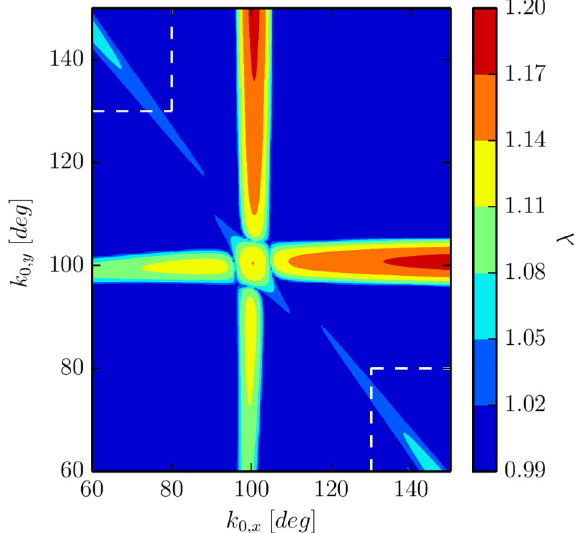
FIG. 9. Tune diagram as scan of growth factor λ obtained from perturbation matrix.